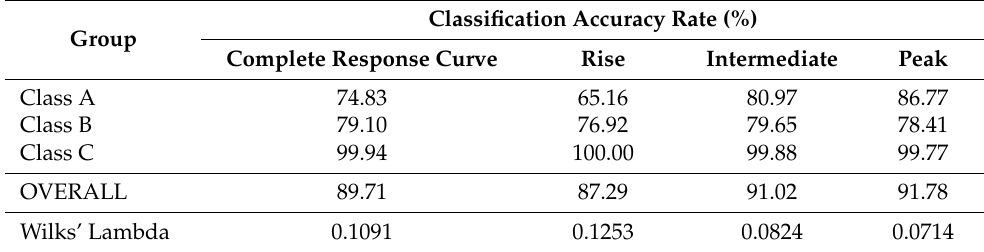
Table 8. Classification accuracy rate results with LDA application and training dataset.